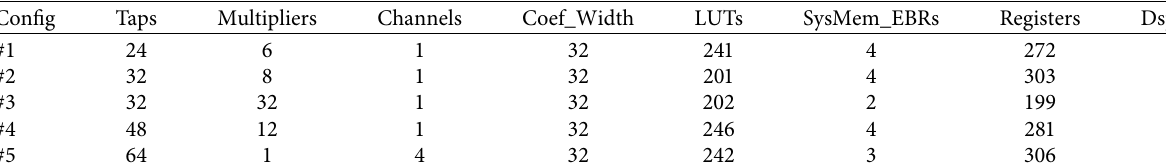
Table 3: FIR filter configurations set.